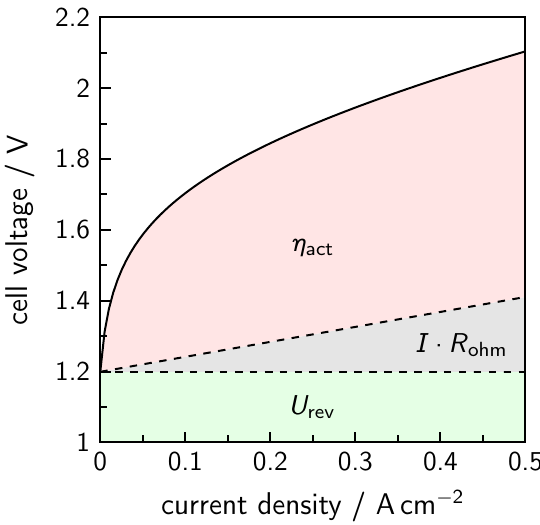
Figure 4. The calculated cell voltage of an atmospheric alkaline water electrolyzer at a temperature of 60 ◦ C according to Equation (8). The overall cell voltage consists of the reversible cell voltage U rev , ohmic losses I · R ohm , and activation overvoltages η act